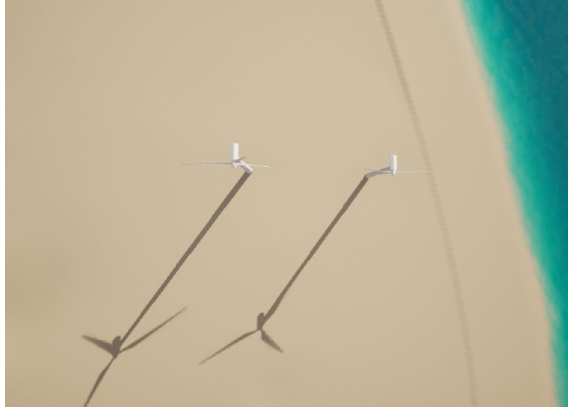
Fig. 7 Screenshot of the environment from the sky